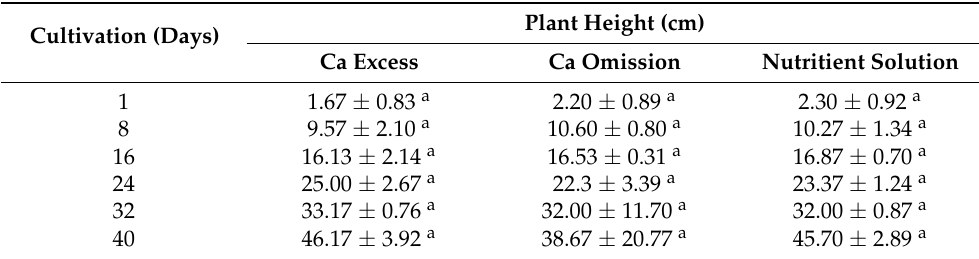
Table 3. Average height of plants grown with different sources of calcium as a function of the cultivation